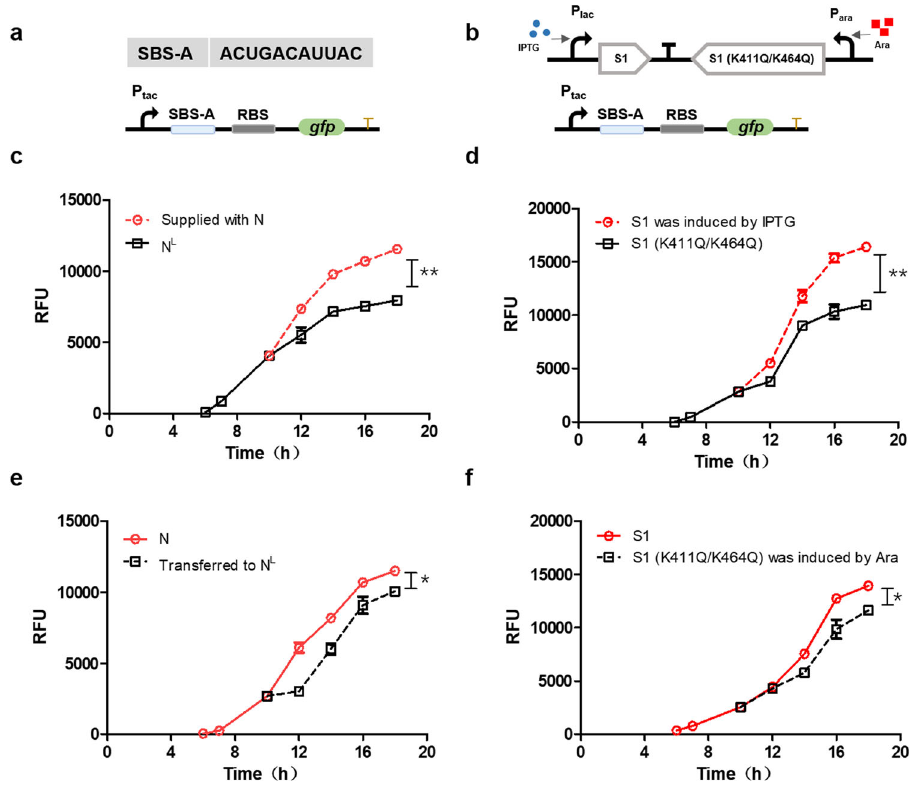
Fig. 5 The speci fi c SBS can be employed to dynamically fi ne-tune gene expression. a Sequence of SBS-A and schematic of the SBS-A testing system (pKD236-P tac -SBS-A-GFP) in E. coli BL21. b E. coli BL21 with pET-28a-S1 (induced by IPTG) and acetyl-mimetic S1 (induced by arabinose). c Expression of GFP (relative fl uorescence unit) in E. coli BL21 cultured in N L or supplemented with nitrogen (N) at 10 h. The black line represents the RFU of GFP in E. coli BL21 cultured in N L , the red line represents the RFU of GFP in E. coli BL21 after addition of nitrogen in N L at 10 h. * P < 0.05, ** P < 0.01, *** P < 0.001. Three replicates were made for each sample. d Expression of GFP in E. coli BL21 cultured in N or transferred to limited nitrogen (N L ) at 10 h. The red line represents the RFU of GFP in E. coli BL21 cultured in N, the black line represents the RFU of GFP in E. coli BL21 after transferring to N L at 10 h. * P < 0.05, ** P < 0.01, *** P < 0.001. Three replicates were made for each sample. e Expression of GFP in E. coli BL21 with pET-28a-S1-S1 (K411Q/K464Q) when cultured in LB medium. Arabinose was added to induce S1 (K411Q/K464Q) at 0 h, and IPTG was added to induce S1 at 10 h. The black line represents the RFU of GFP in E. coli BL21 with arabinose, the red line represents the RFU of GFP in E. coli BL21 after adding IPTG at 10 h. * P < 0.05, ** P < 0.01, *** P < 0.001. Three replicates were made for each sample. f IPTG was added to induce S1 at 0 h, and Ara was added to induce S1 (K411Q/K464Q) at 10 h. The red line represents the RFU of GFP in E. coli BL21 with IPTG, the black line represents the RFU of GFP in E. coli BL21 after adding arabinose at 10 h. * P < 0.05, ** P < 0.01, *** P < 0.001. Three replicates were made for each